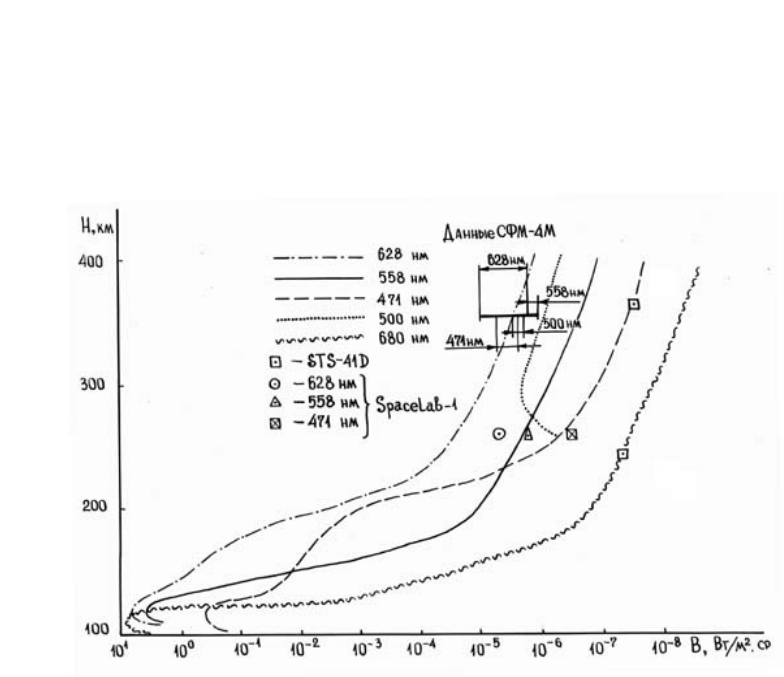
Figure 5 – Calculation of the height range of the brightness of nonequilibrium luminance in comparison with experimental